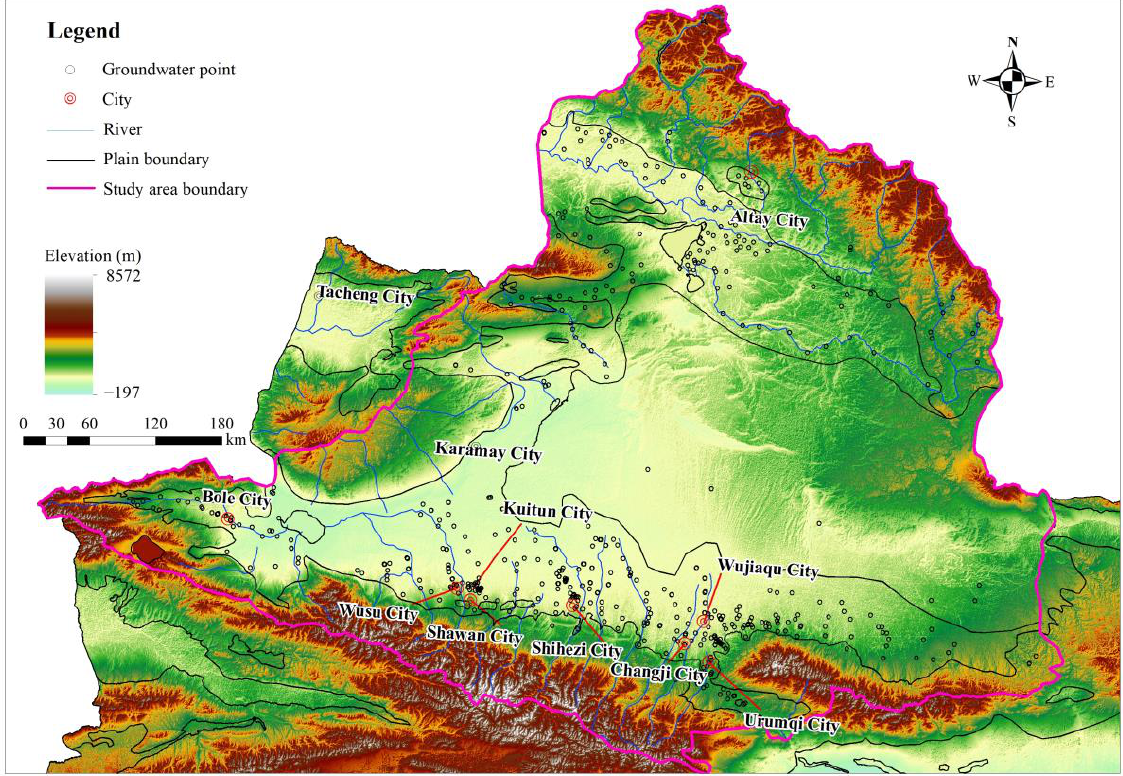
Figure 2. Distribution of groundwater sampling points in the study area.